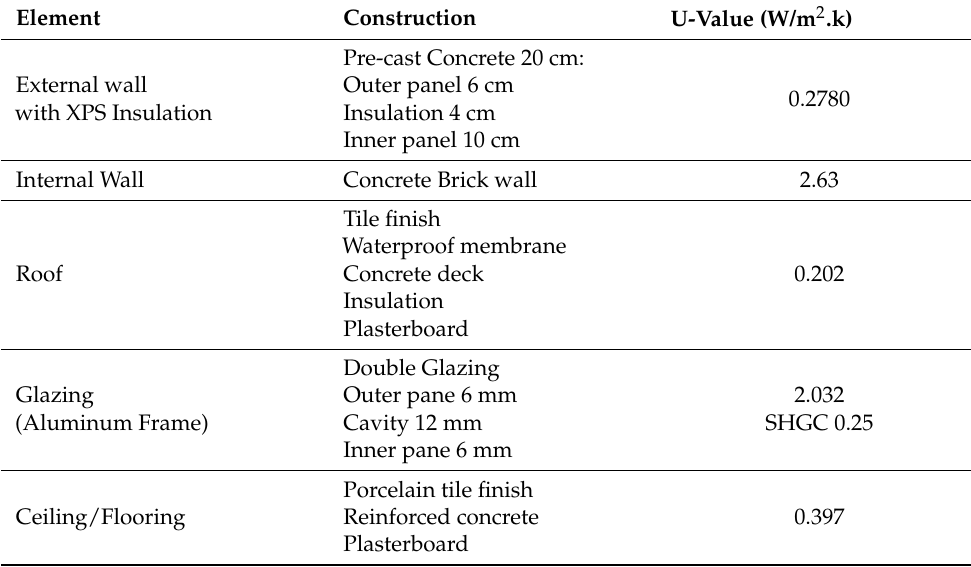
Table 2. Material properties of building construction.